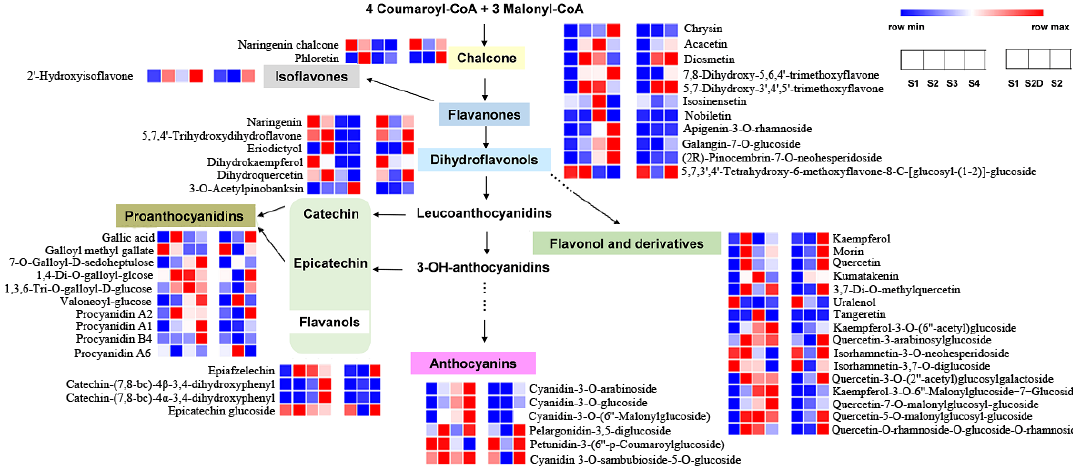
Figure 7. Differential metabolite enrichment in flavonoid biosynthesis and their accumulation profiles in developing rose flowers by heatmap.